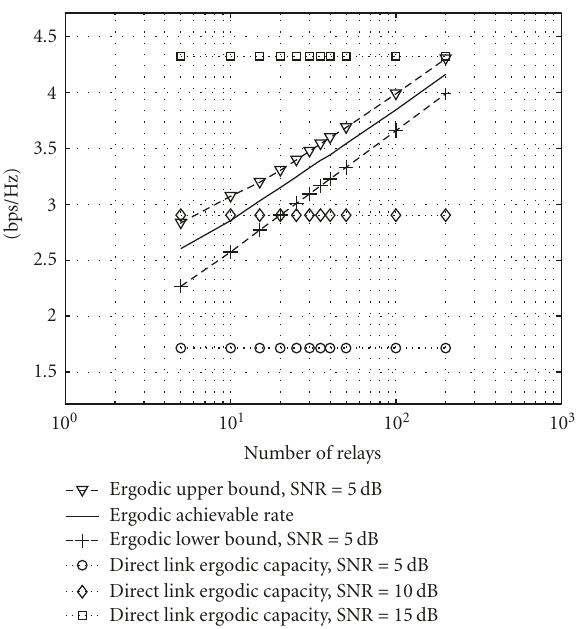
Figure 3: Ergodic achievable rate in [bps/Hz] of a Gaussian multi- ple relay channel with transmit SNR = 5dB, under Rayleigh fading. The upper and lower bounds proposed in the paper are shown, and the ergodic capacity of a direct link plotted as